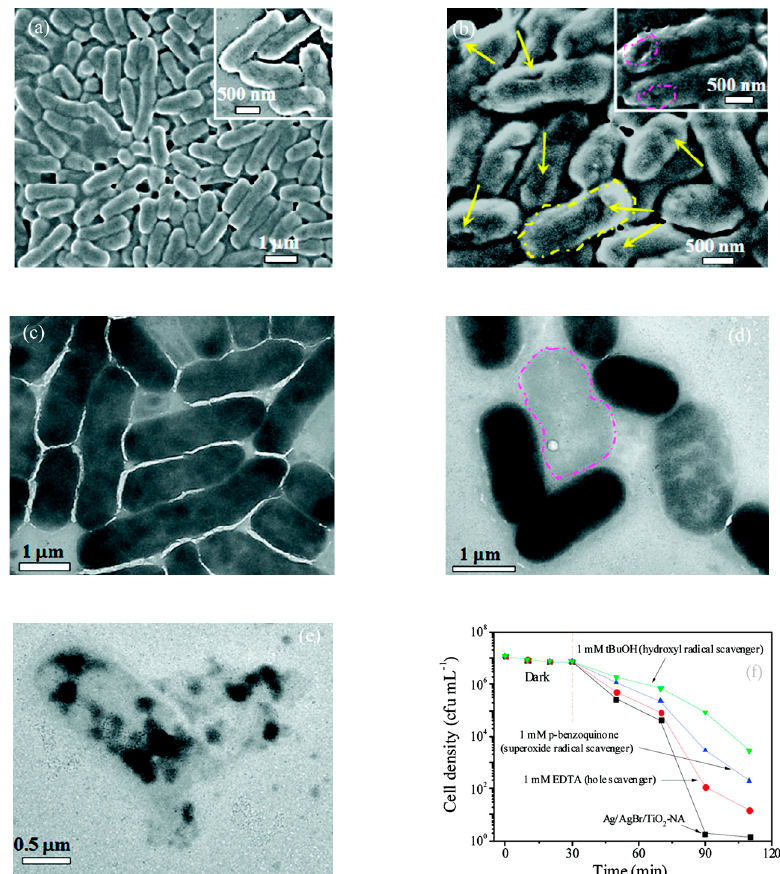
Figure 4. E. coli decomposition presented as a decrease in bacteria number (closed symbols) and CO 2 evolution (open symbols), tested in the suspension of titania under vis irradiation ( λ > 450 nm) and in the dark; adapted with permission (after formatting) from [114]. Copyright 2015 Elsevier.